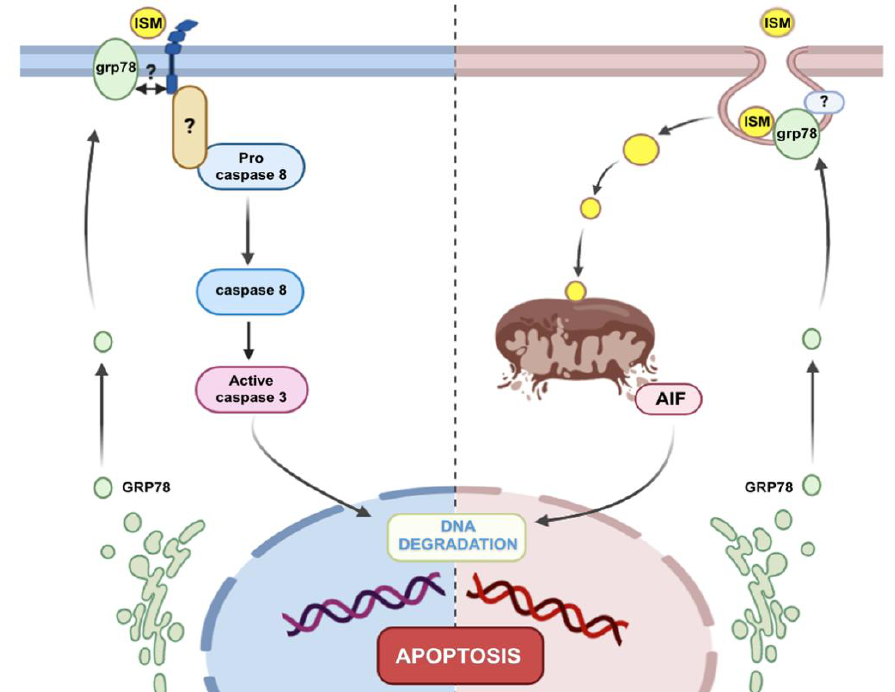
Figure 8. Proposed mechanism of the deleterious action of ISM1 on podocytes. (Left) Caspase-dependent pathway. At low concentration, extracellular ISM1might bind αvβ5 and/or GRP78 at the cell surface, triggering activation of procaspase-8 and the downstream effector caspase-3, which would activate a caspase-dependent DNAse (CAD) to produce DNA fragmentation (left). At higher concentrations, ISM1 is internalized by endosomal trafficking and would induce the activation of a caspase-independent proapoptotic pathway. Thus, ISM1 potentially interacts with GRP78 on the cell surface and would trigger its endocytic transport into the mitochondria. Subsequently, ISM1 triggers the permeabilization of the outer mitochondrial membrane and the specific release of AIF into the cytosol. Ultimately, AIF translocates to the nucleus where it contributes to DNA fragmentation and chromatin condensation.